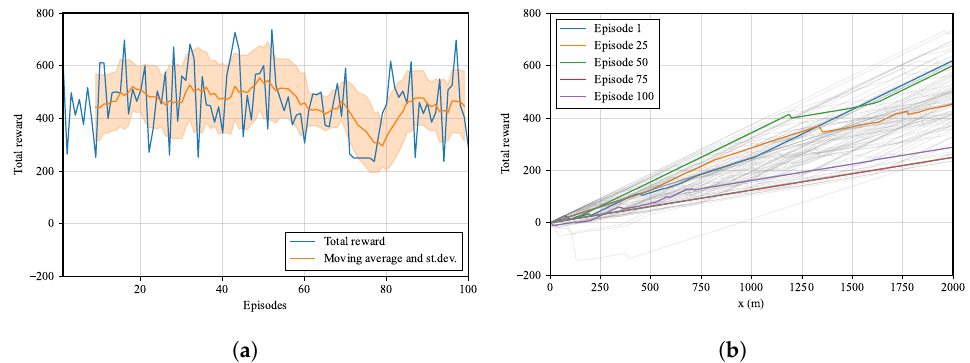
Figure 8. Rewards of the random environment: ( a ) Cumulative reward vs. no. of episodes; moving average and interval of range ± one standard deviation of ten episodes (orange band). ( b ) Cumulative reward vs. excavation step for all episodes.